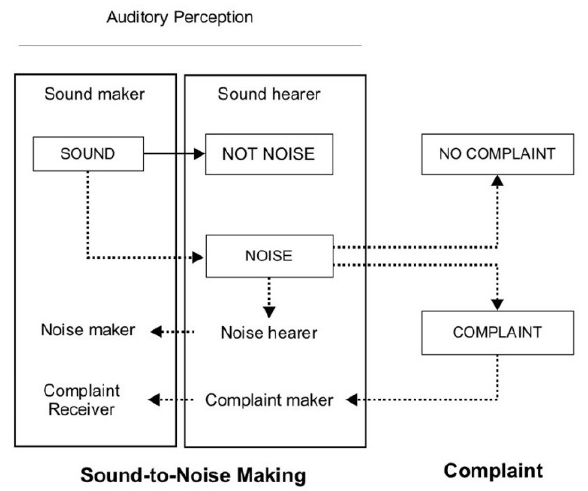
Figure 1. Framework of sound-to-noisemaking and noise complaint.